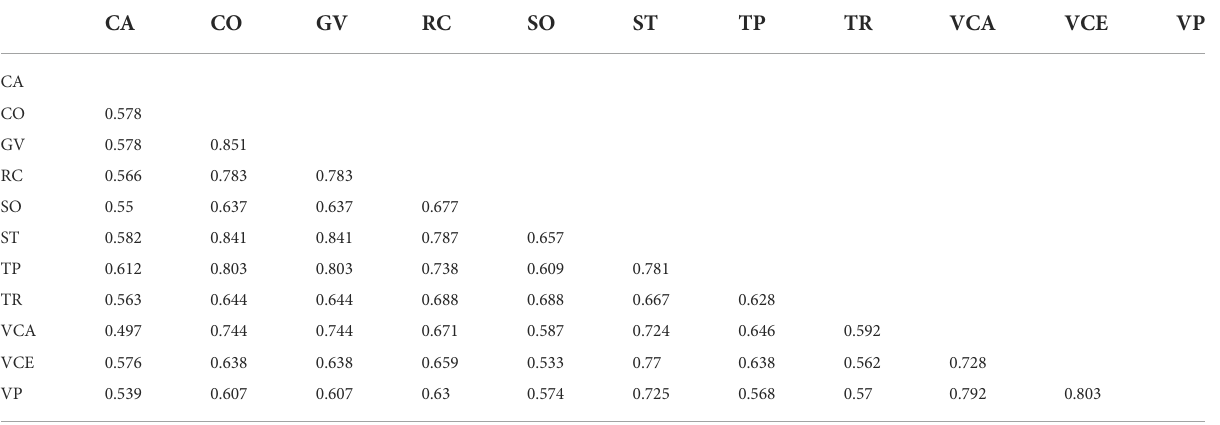
TABLE 7 Heterotrait-Monotrait ratio (HTMT).